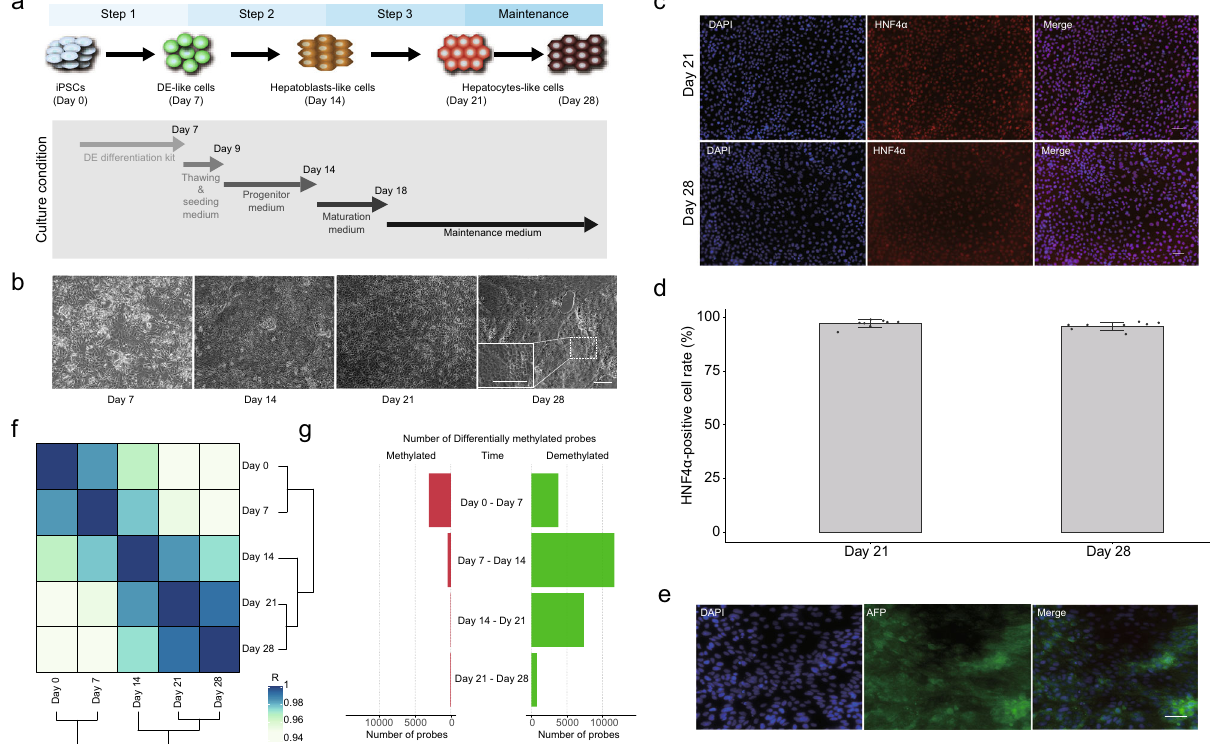
Fig. 1 Time-course methylome analysis of hepatocyte differentiation. a Schematic illustration of in vitro hepatocyte differentiation and culture condition of each step. b Representative micrographs of cells at each time point. The scale bar is 100 μ m. At the bottom left of day 28, a higher magni fi cation image of the area surrounded by the doted-square shows. c Immunocytochemistry for HNF4 α . The scale bar is 50 μ m. d Bar plot showing the average rate of HNF4 α stained nuclei. The error bar is s.d. Dots represent the individual data. The data were collected from four different fi elds of a culture well in two biological replicates. e Immunocytochemistry for AFP. The scale bar is 50 μ m. f A correlation matrix with hierarchical clustering. The color represents the correlation coef fi cient (R). g The number of differentially methylated